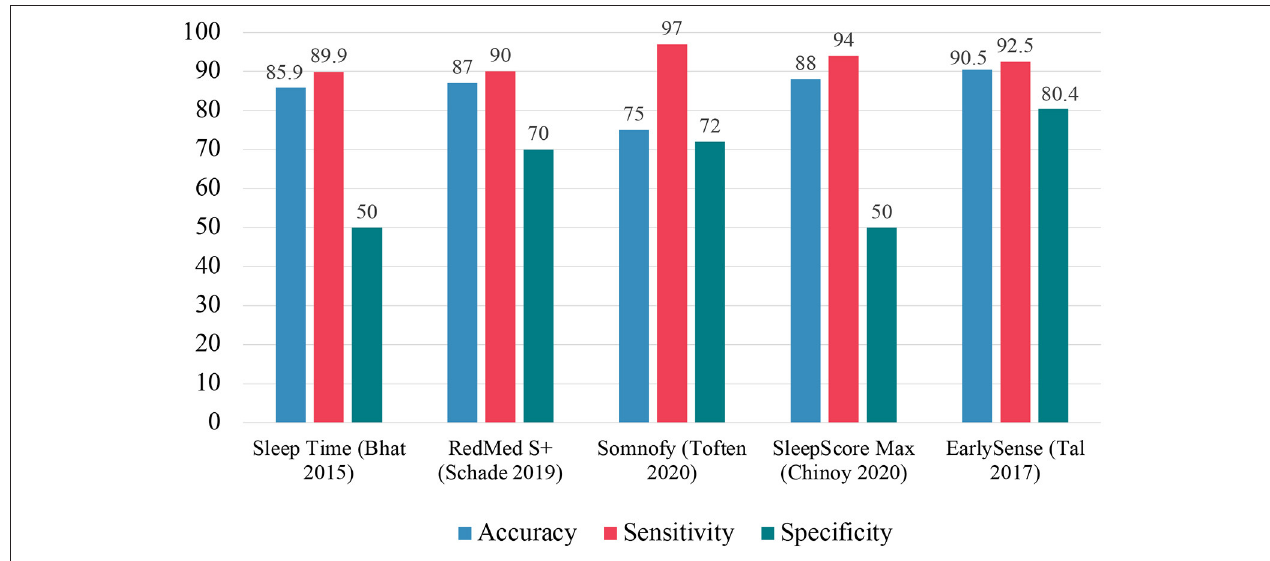
FIGURE 6 | Summary of EBE analysis for other consumer sleep